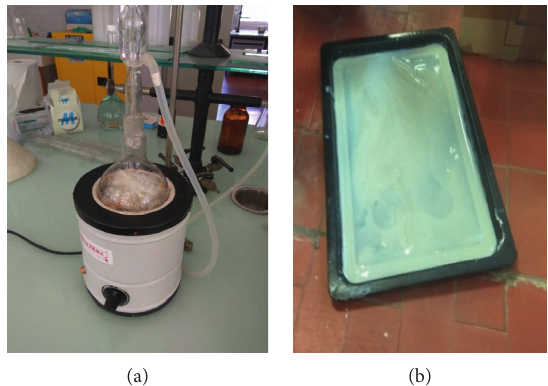
Figure 1: (a) Close system of chemical recycling step; (b) depolymerization of polyethylene terephthalate (DPET) after a liquid separation. Table 2: Mixture typologies with the sand type used and the weight replacement of sand by DPET. Cement paste